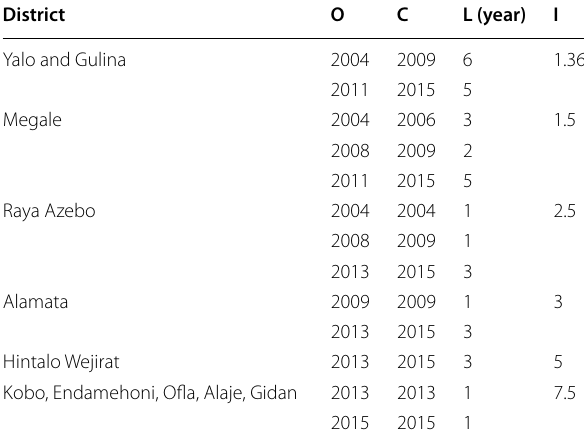
Table 2 Analysis of agricultural drought onset (O), ces- sation (C), duration (L), and recurrence interval (I) in the study area. Source: Gidey et al.